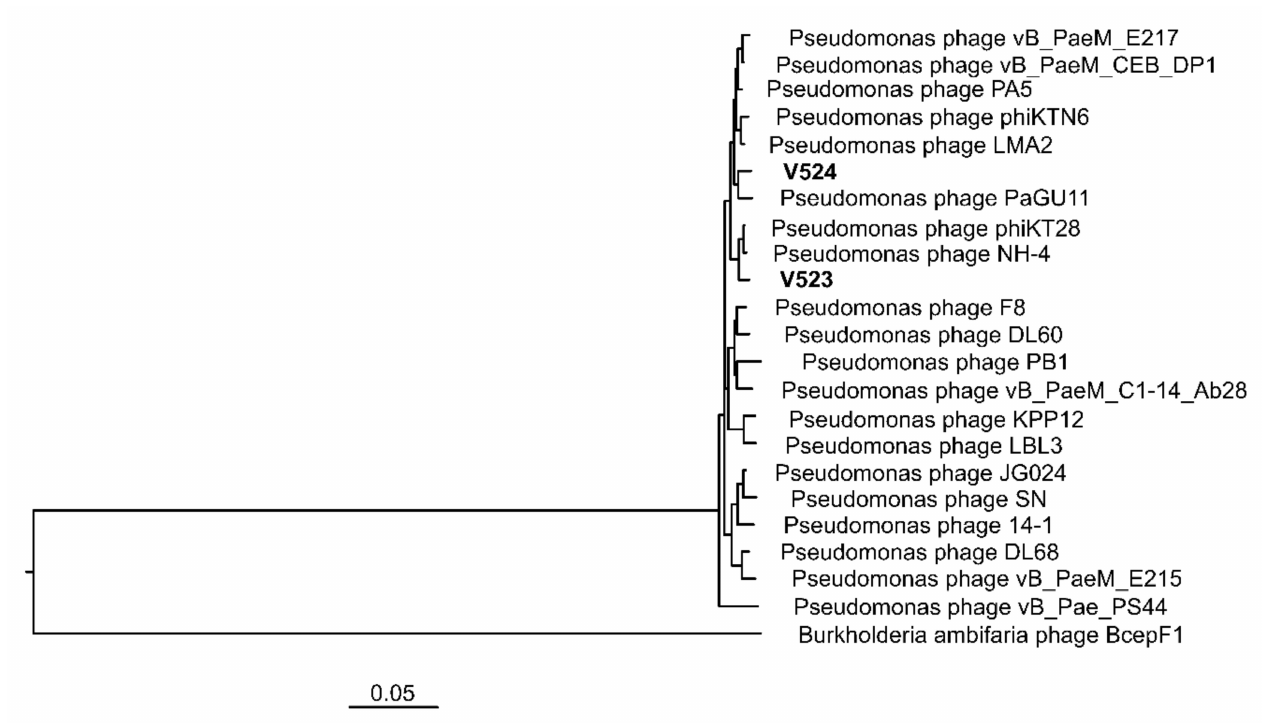
Figure 5. A VICTOR tree produced with FastME based on nucleotide identity calculated with the D0-formula [40], with the newly isolated phages (V523 and V524) and reference genomes within the Pbunavirus genus and closely related published Pbunavirus phage strains. Accession numbers for previous phage isolates can be found in Supplementary Table